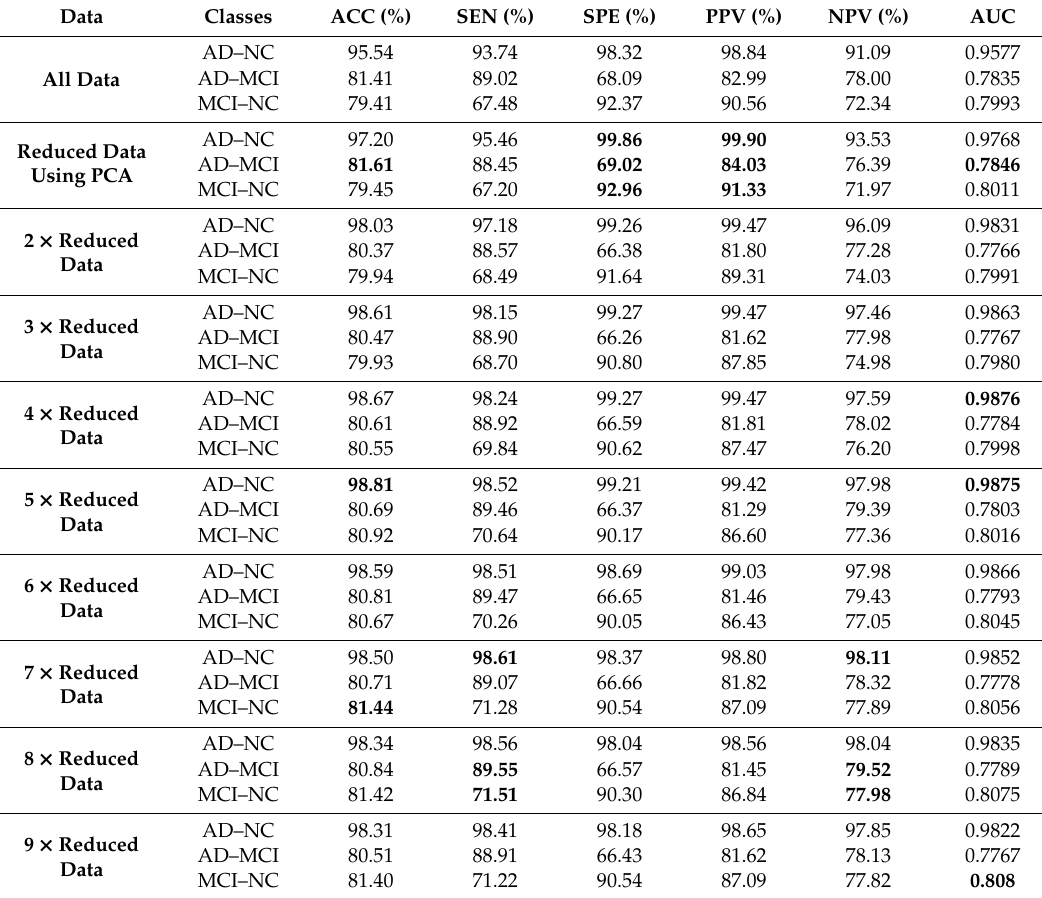
Figure 6. Comparison of changes in average accuracy, sensitivity and specificity for 15, 20, 25, and 30 PCA elements in 1–9 × repeated feature reduction, and all the features (black line). Table 2. Comparing performance metrics. Classification accuracy (ACC), sensitivity (SEN), specificity (SPE), positive predictive value (PPV), negative predictive value (NPV), and area under the curve (AUC) for all features and 25 principal component analysis (PCA)